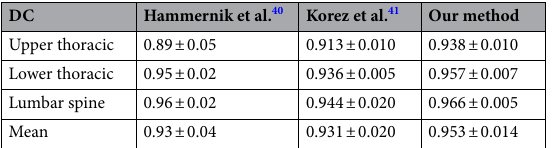
Table 7. Comparison with some state-of-the-art traditional methods.